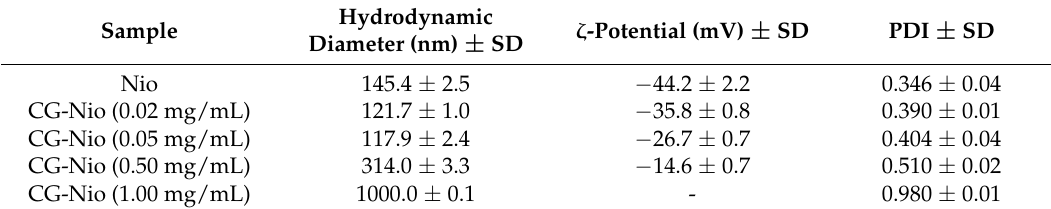
Table 1. Niosomal dimensions (nm) and ζ -potential (mV) values obtained by adding of